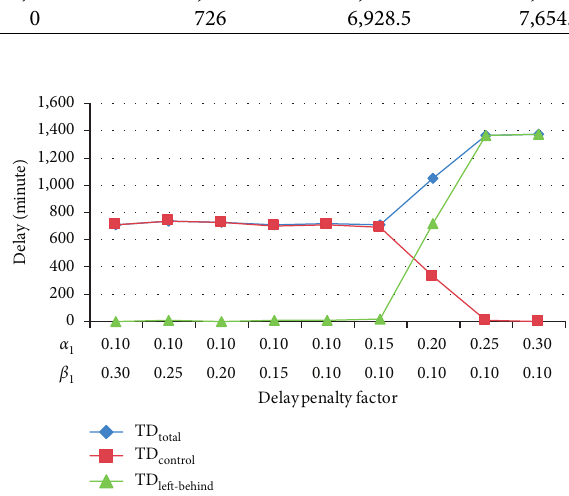
Figure 6: The results of Model I with different